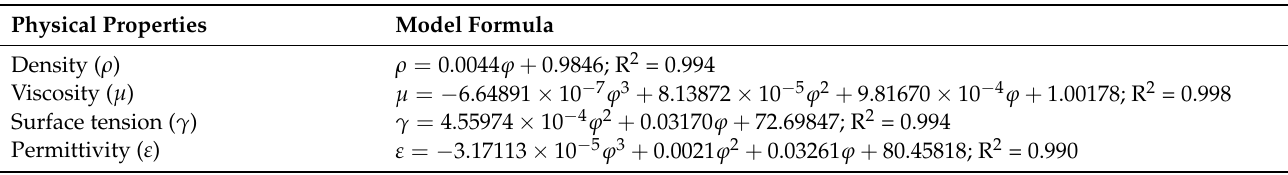
Figure 1. The physical properties of H 2 O 2 solutions at the room temperature of ~20 °C. ( a ) Density; ( b ) Viscosity; ( c ) Surface tension; ( d ) Relative permittivity.